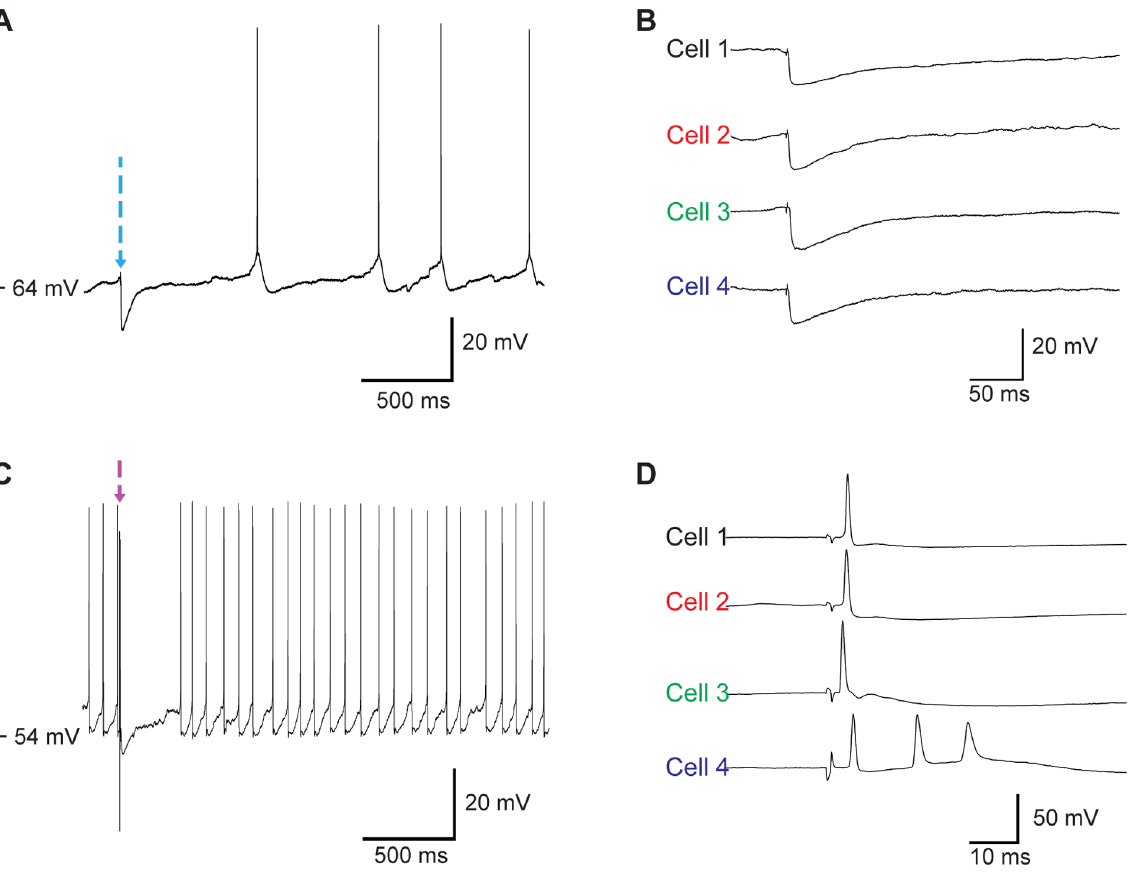
Figure 5. Invitro brain slice intracellular recording from mouse, cortical neurons. (A) Light-evoked inhibitory post synaptic potential (IPSP) recorded with a CNT probe from a neuron in cortical brain slice prepared from a VGAT-CHR2 mouse. A brief light pulse was applied at the time marked by the arrow (V m = 2 64 mV). (B) Expanded membrane potential records for CHR2 evoked IPSPs collected from four different cortical neurons. (C) Electrically-evoked excitatory postsynaptic potential (EPSP) from a cortical neuron in a mouse cortical brain slice (V m = 2 54 mV). (D) Expanded membrane potential records of electrically-evoked EPSPs collected from four different cortical neurons.